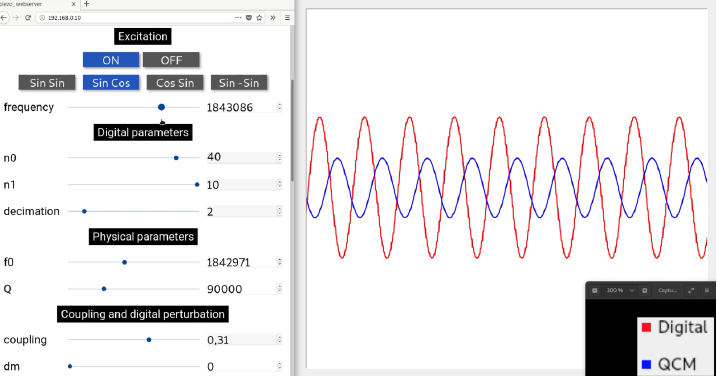
Figure 6. Graphical user interface (GUI) screenshot: Webserver on the left (buttons, sliders, and spin boxes for parameters tuning) and GNU radio on the right (numerical